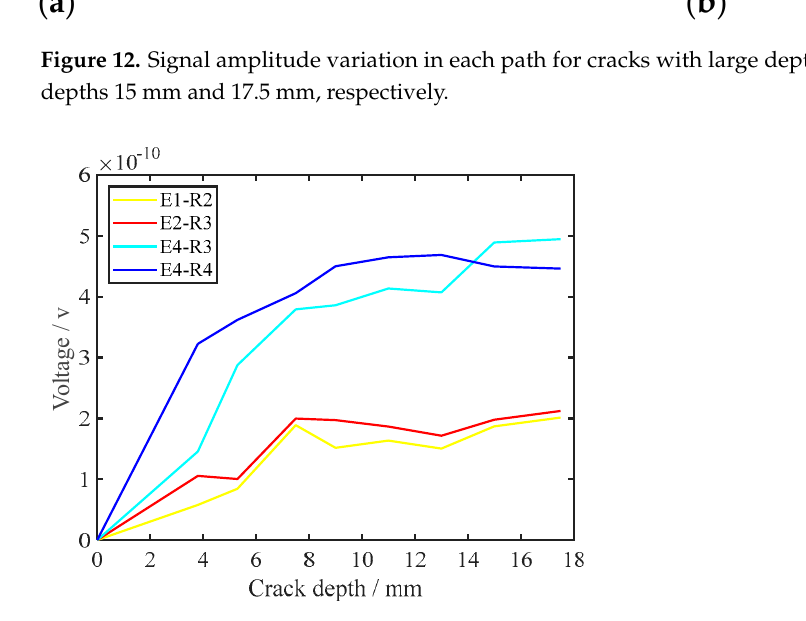
Figure 13. Signal amplitude variation at different crack depths in the same path.